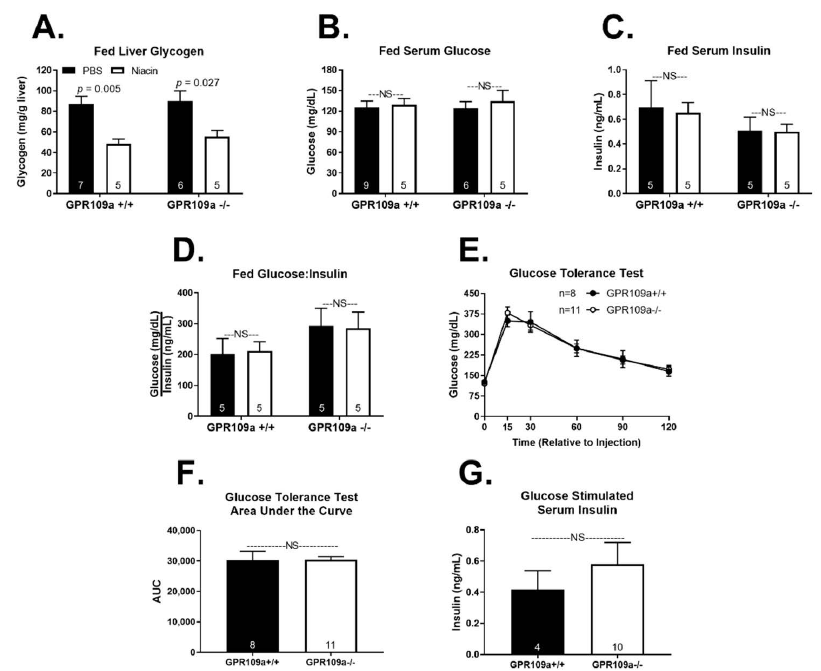
Figure 1. Effect of niacin on glucose homeostasis in fed GPR109a +/+ and − / − mice. Hepatic ( A ) glycogen (mg/g liver tissue), serum ( B ) glucose (mg/dL), ( C ) insulin (ng/mL), and ( D ) glucose:insulin ratio. Direct comparisons were made between injection treatment within genotype. ( E ) Glucose tolerance test in 4-h fasted mice. ( F ) Glucose tolerance test area under the curve. ( G ) Glucose stimulated serum insulin. Bars were analyzed by a two-sided unpaired t -test. NS = non-significant; p > 0.05; PBS = phosphate-buffered saline. Numbers inside bars denote the n per group.